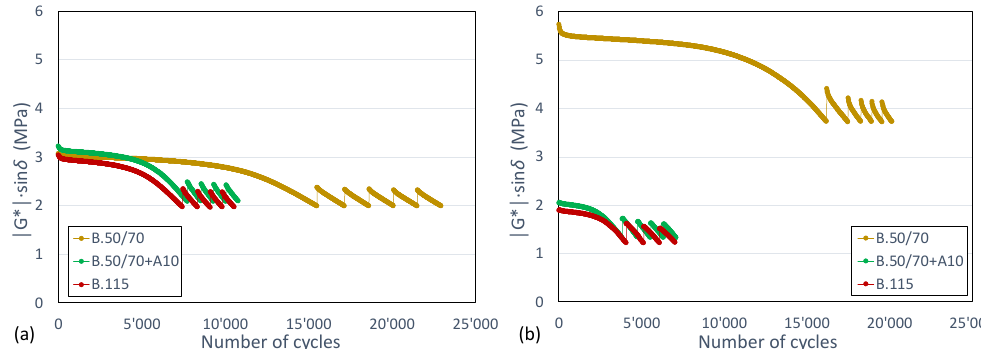
Figure 5. Comparison among unaged binders in ( a ) iso-stiffness and ( b ) iso-thermal conditions in terms of evolution of |G ∗ | ∙ sinδ versus number of loading cycles.